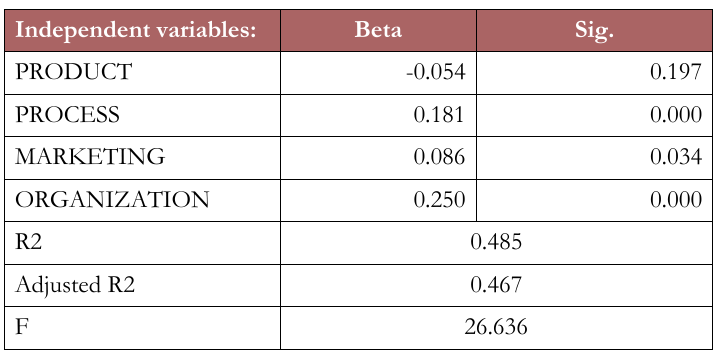
Table 4. Regression analysis results for branch 1